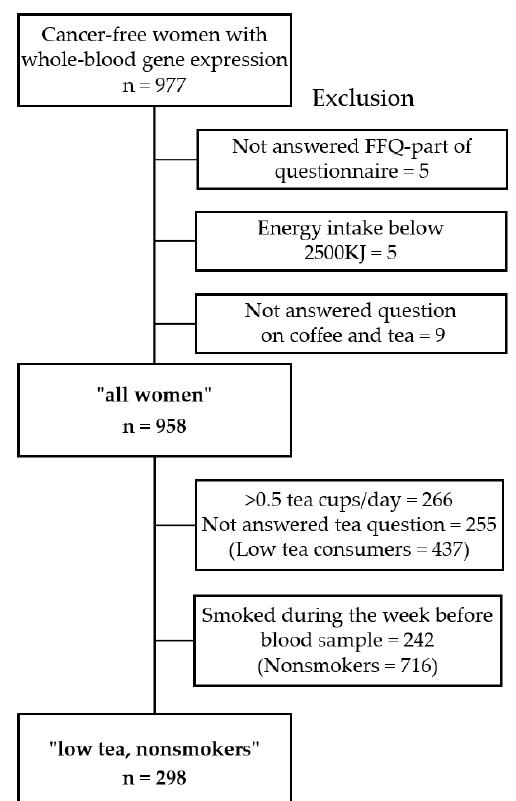
Figure 1. Flowchart showing the exclusion criteria in the study group and number of cancer-free women included in the study.